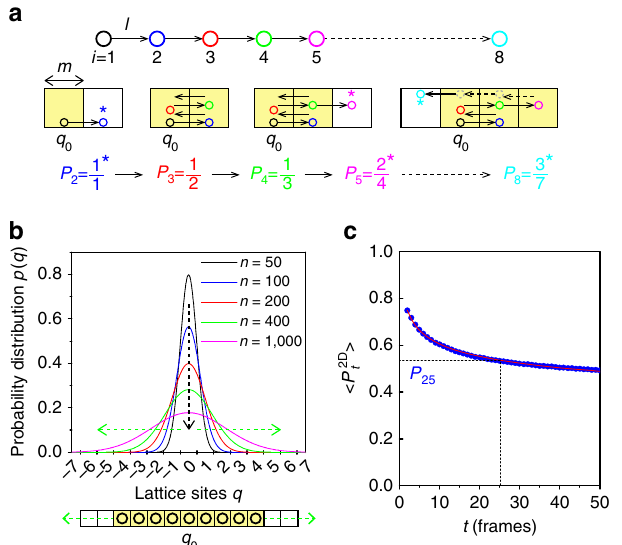
Figure 1 | Theoretical framework of lattice occupancy analysis. ( a ) Schematic diagram illustrating the motion of a single particle on 1D lattice frame. The motion starts at lattice site q 0 of side length m where the particle moves either to the right or to the left with step size l ¼ m . The probability of occurrence of visits to new lattice sites at time t ( P t ) decreases as t increases. ( b ) Probability distribution ( p ) of finding a particle at different lattice sites after n steps ( n ¼ t / t ) calculated using 1D random diffusion theory (equation (2)). The s.d.‘s increase (green dashed lines), whereas the peak heights decrease (black dashed lines) with the square root of n (equation (2)) ( c ) Average probability of occurrence of visits to new lattice sites at time t ( o P t 2D 4 ) obtained from 100 simulated 2D random diffusion trajectories. The lattice size ( m ) was set to 160nm. The step sizes of the trajectories were generated using equation (5) ( r ¼ 160nm). The red line shows the fitting to equation (4). The scaling exponent ( b ) obtained by the fitting is 0.133 for the random walk. mode (low P 25 value or a few visits to new lattice sites) and a low lattice occupancy mode (high P 25 value or more visits to new lattice sites). We collectively refer to the modes that result from the lattice occupancy analysis as relative modes (Fig. 2d).